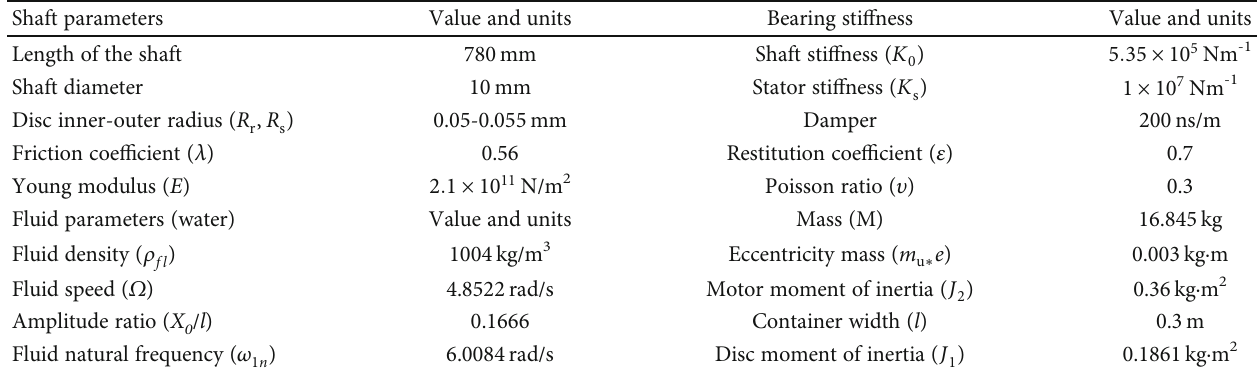
Table 1: Parameters of the rotor-stator system for the simulations.